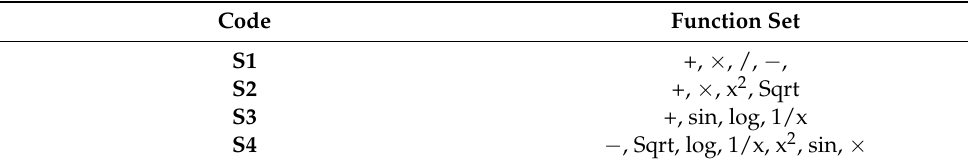
Table 3. List of function sets .